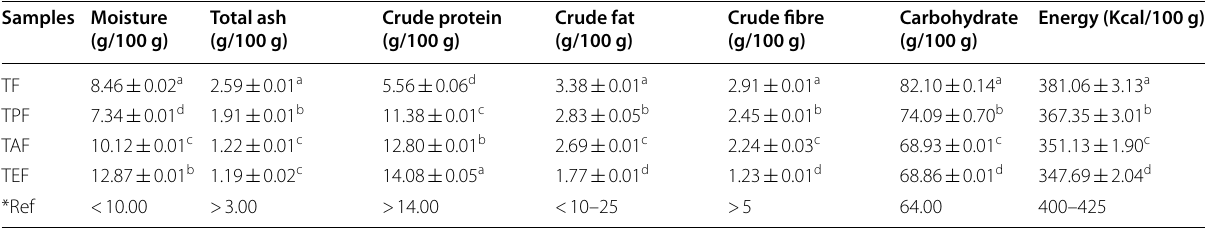
Means ( SEM) with different alphabetical superscripts in the same column are significantly different at P < 0.05 ± TF Native tacca flour, TPF Tacca physical flour, TAF Tacca acetylated flour, and TEF Tacca enzymatic starch *Ref - stands for standard values of the components